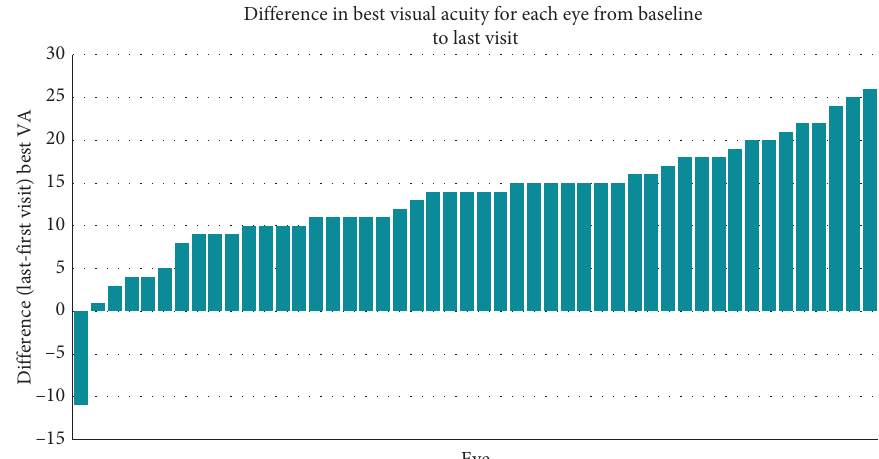
Figure 6: The waterfall plot showing differences from baseline to study end in best VA for each eye in the investigation. Only 1 is below the line, while the rest show some acuity improvement such that 42 of the 48 eyes have an improvement of 5 letters or more. Table 4: VA and contrast sensitivity determinations that show differences between baseline and exit. While there is no significant im- provement in contrast sensitivity, there is a highly significant letters’ improvement in VA in both parametric and nonparametric testing.